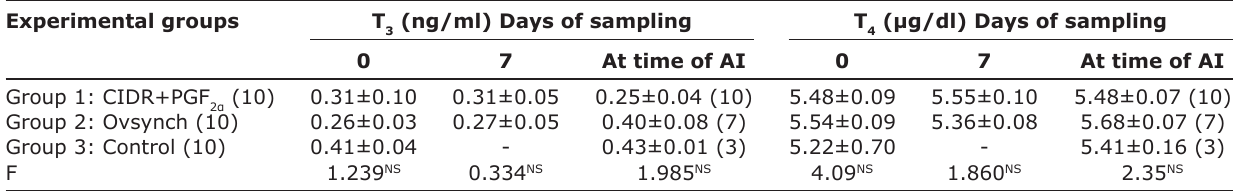
) and thyroxine (T ) concentration of various experimental groups on different 3 4